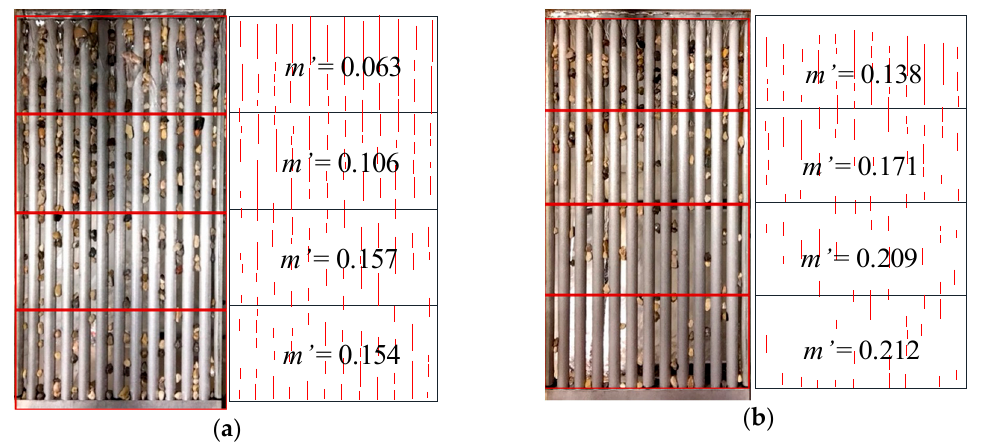
Figure 8. Top view of occluded bottom racks with circular bars for m = 0.60, dividing the rack into four parts, with the void ratio calculated from occluded areas: ( a ) q 1 = 155.5 l/s/m and 10% longitudinal slope and ( b ) q 1 = 198.0 l/s/m and 35% longitudinal slope.